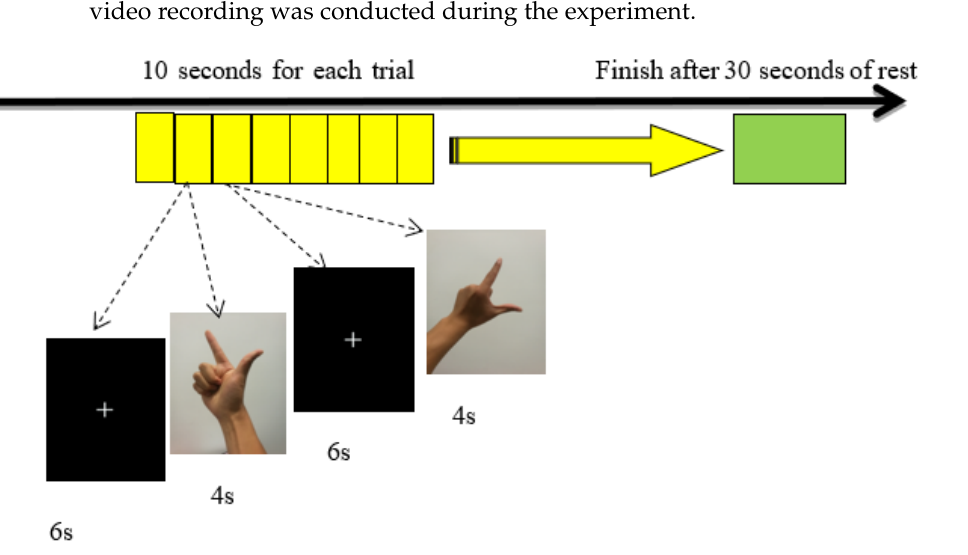
Figure 1. Flow chart of the imitation tasks.